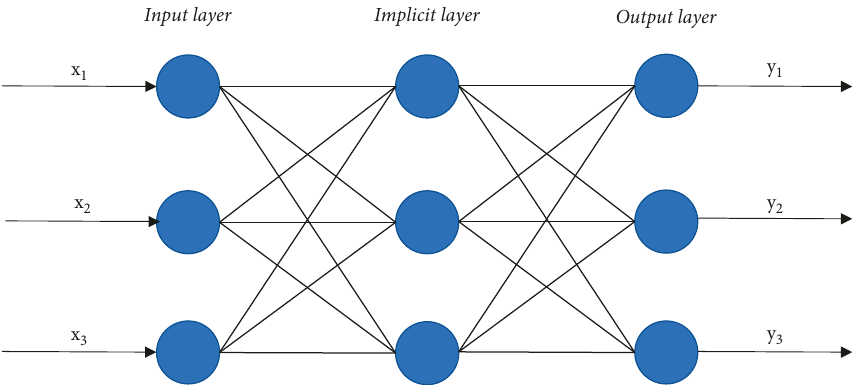
Figure 1: Framework of BP neural network